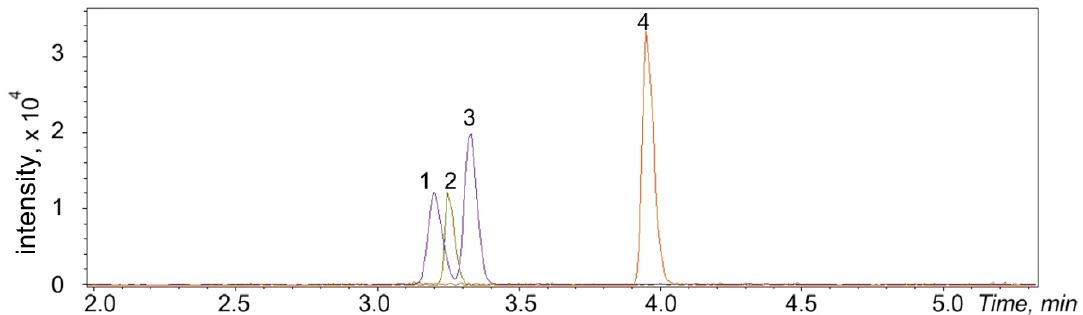
Figure 6. LC-HRMS chromatogram of catecholamines and gabapentin derivatives in synthetic urine at quality control (QC) low (10 ng/mL) concentration: 1—PG-octopamine, 2—PG-adrenaline, 3—PG-dopamine, 4—PG-gabapentin (IS).